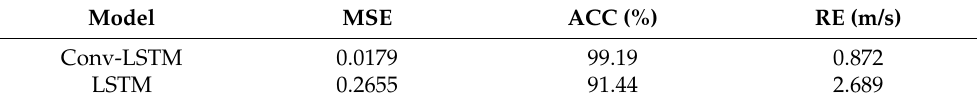
Figure 9. Prediction of LSTM and Conv-LSTM network. Table 2. Predicted results of different models with 24 time steps at (24.5° N, 169.5°